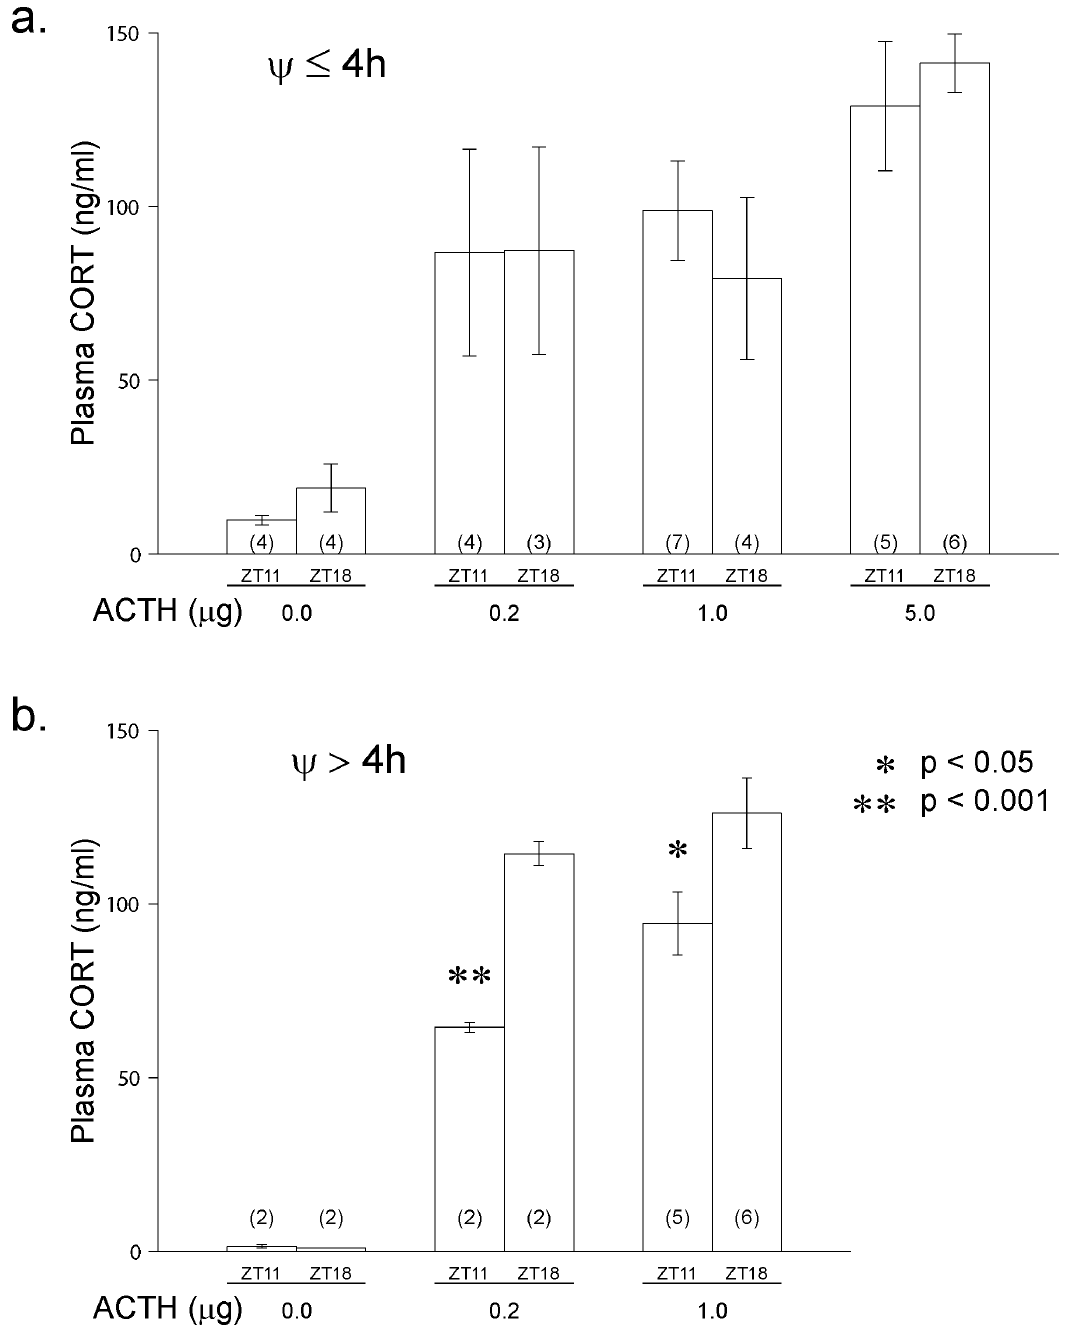
Figure 8. Circulating CORT levels after ACTH challenge. Mice in 8L:14D entrained with (a) Y s # 4 h delayed and (b) Y s . 4 h delayed were pretreated with dexamethasone (100 m g/kg ip) and 2 h later were challenged with either vehicle or ACTH (0.2, 1.0 or 5.0 m g ACTH/mouse ip). Blood samples were collected 20 min after ACTH injection at either ZT 11 or ZT 18. All CORT values after ACTH injection were significantly greater than CORT values following vehicle injection (p , 0.01). ZT11 significantly different from ZT18, *=p , 0.05; **=p , 0.001. (n)=number